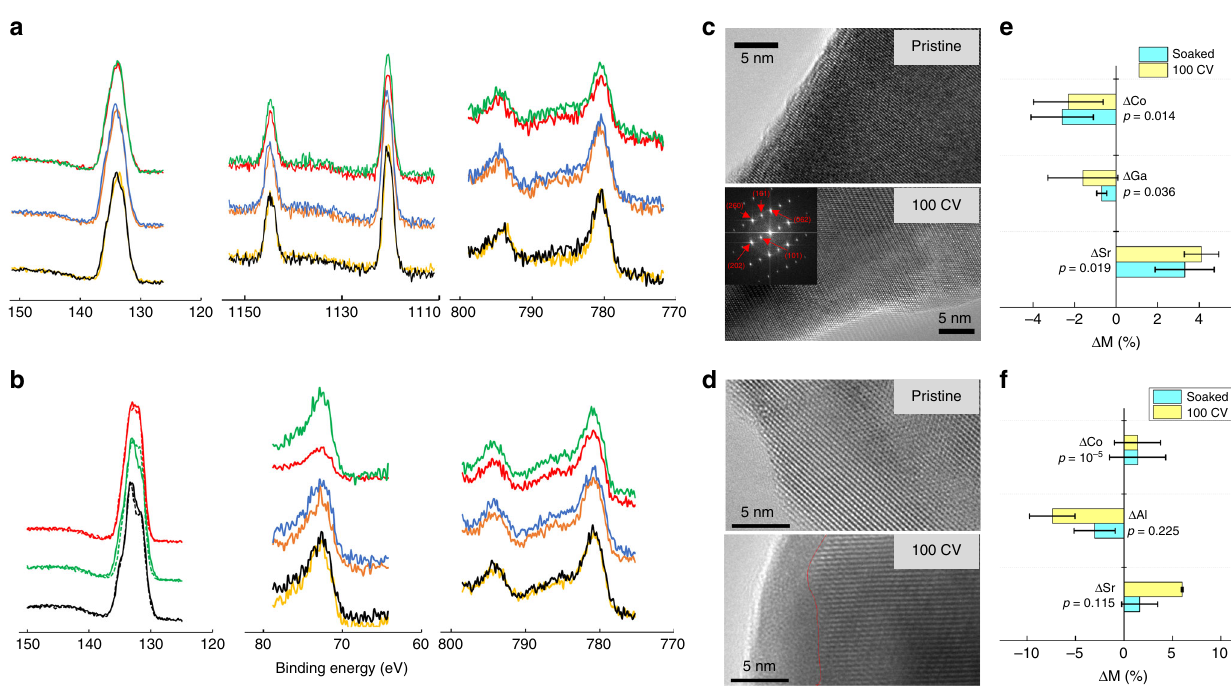
Fig. 3 Structural and compositional stability of Sr 2 GaCoO 5 under oxygen evolution conditions in neutral-pH. a X-ray photoelectron spectroscopy results for Sr 3d (left), Ga 2p (middle) and Co 2p (right) signal in Sr 2 GaCoO 5 . b X-ray photoelectron spectroscopy results for Sr 3d (left), Al 2p (middle) and Co 2p (right) signal in. Each fi gure contains three groups of spectra, corresponding to pristine sample (bottom), sample soaked in the electrolyte for four hours (middle) and sample after 100 cyclic voltammetry cycles from 1.0 to 1.7 V (top). For each group, the bottom one shows the signal from fresh surface and the top one shows the signal after Ar + sputtering for 16 min The signal of Al is magni fi ed by 10 times for better visualization. c , d HRTEM images of Sr 2 GaCoO 5 ( c ) and Sr 2 AlCoO 5 ( d ) for pristine sample and for sample after 100 cyclic voltammetry scans from 1.0 to 1.7 V. The insert in c shows the indexed selected area electron diffraction. The red line marked the boundary between the crystalline and amorphous regions. e Difference of cation content between on the surface and in the bulk of Sr 2 GaCoO 5 from 10 energy dispersive spectroscopy measurements. f Difference of cation content between on the surface and in the bulk of Sr 2 AlCoO 5 from 15 energy dispersive spectroscopy measurements. The statistical signi fi cance of the difference between soaked and cycled samples was evaluated in the equivalence test, designed as two one-side t -tests to test if the difference is larger than θ or smaller than − θ , where the acceptance criterion θ was chosen to be the average standard deviation of metal content, 2%, for Sr 2 GaCoO 5 . Due to the obviously larger change of Sr and Al contents in Sr 2 AlCoO 5 samples, we used a larger acceptance criterion θ , 5%, in the test. The largest p -value at 95% con fi dence level is reported on the